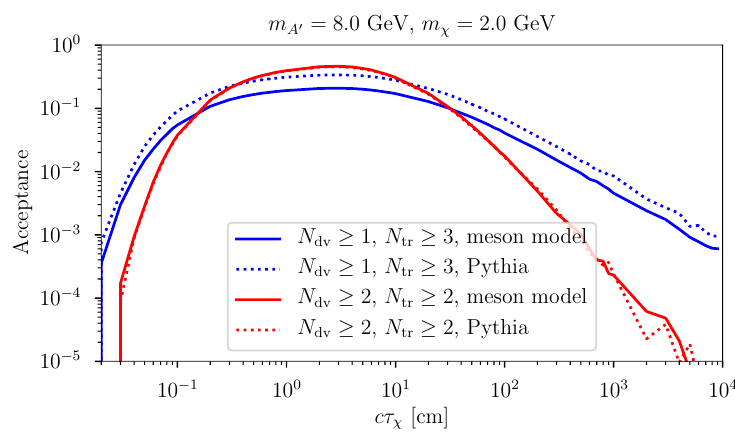
¯ du , comparing results from the meson = 8 GeV , m = 2 GeV A 0 χ